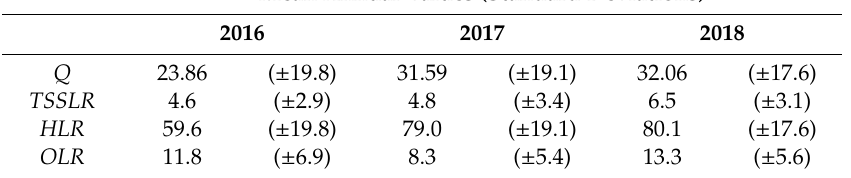
Table 6. Mean annual values of the water inflow rate ( Q ) (m 3 day − 1 ), total suspended solids rate ( TSSLR ) (g TSS m − 2 · day − 1 ), hydraulic loading rate ( HLR ) (mm day − 1 ), and maximum areal organic loading rate ( OLR ) (g BOD 5 m − 2 day − 1 ) of the HSTW unit during the period, 2016–2018. The values are based on the inflow rate through the system. Mean Annual Values (Standard Deviations)